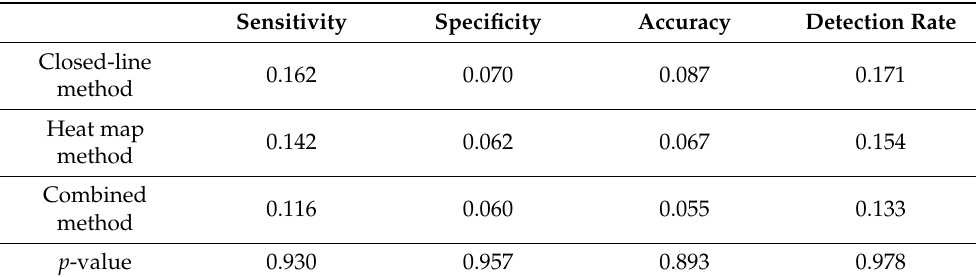
Table 5. Coefficients of variation for performances of readers.